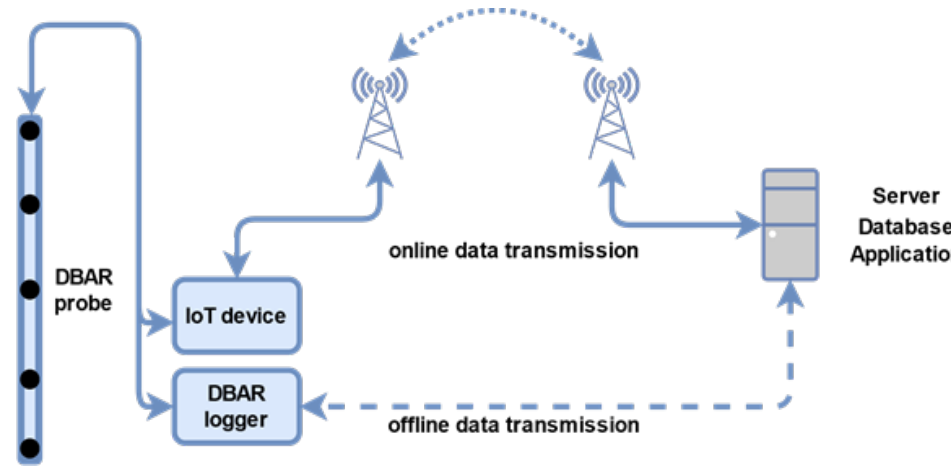
Figure 6. System architecture block diagram.